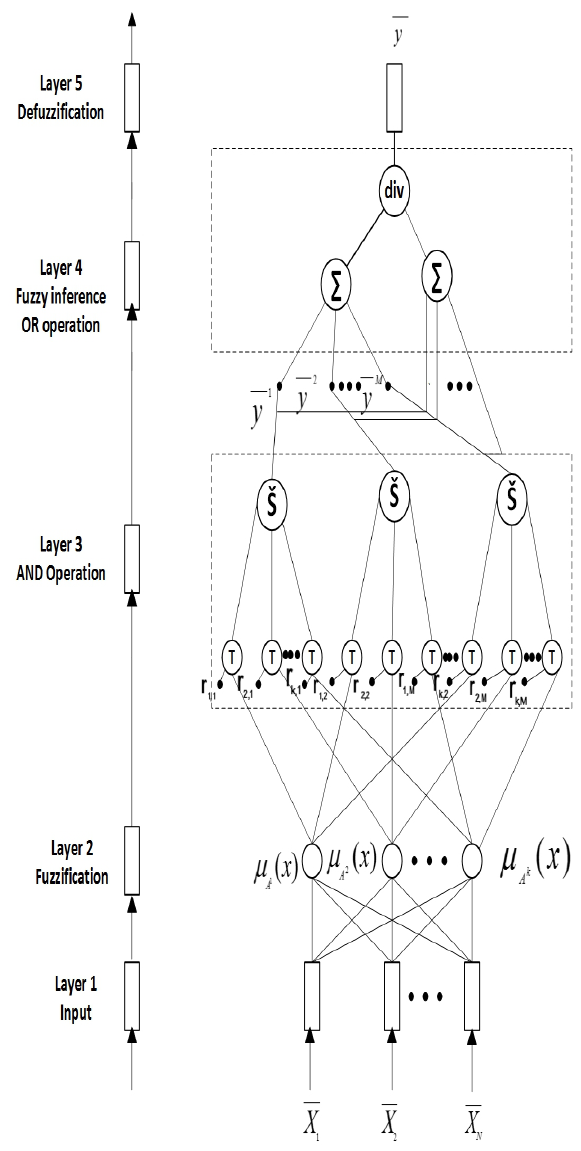
Figure 5. A typical 5 layer NF framework, Adapted from: